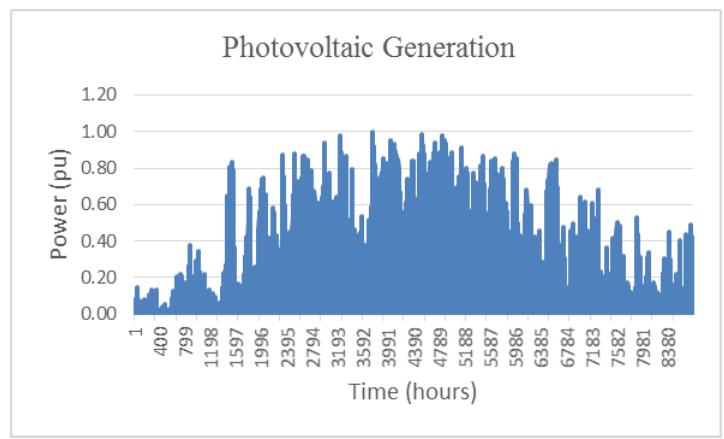
Figure 7. PV generation. Data corresponding to Germany- 50 Hertz (2013) . Sensors 2020 , 20 , x FOR PEER REVIEW